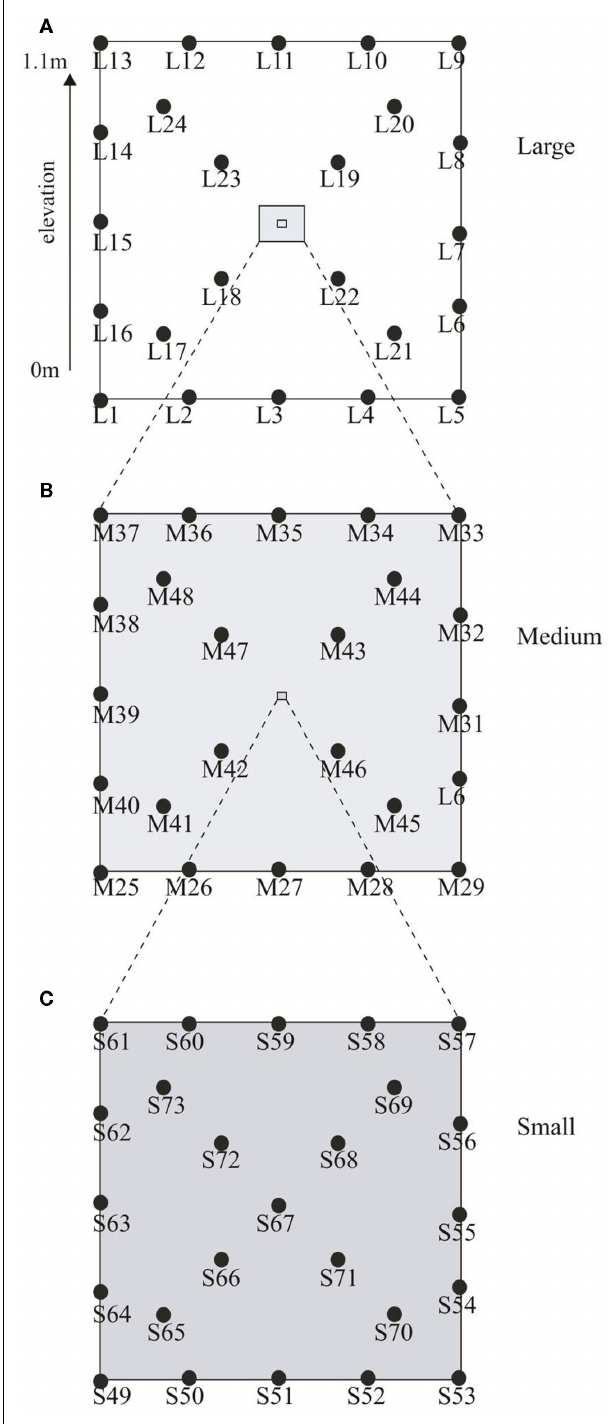
FIGURE 1 | Graphical representation of the sampling scheme. Depicted in (A) is the large-scale plot (10m × 10m) with an elevation from 0 to 1.1m. Samples were taken at 2.5m intervals along the sides and 2.35m intervals along the diagonals. (B) Shows the medium plot (1m × 1m) with sampling interval of 25cm along the sides and 23.5cm along the diagonals while (C) depicts the small plot (20cm × 20cm) with samples intervals of 5.0cm along the sides and 4.7cm along the